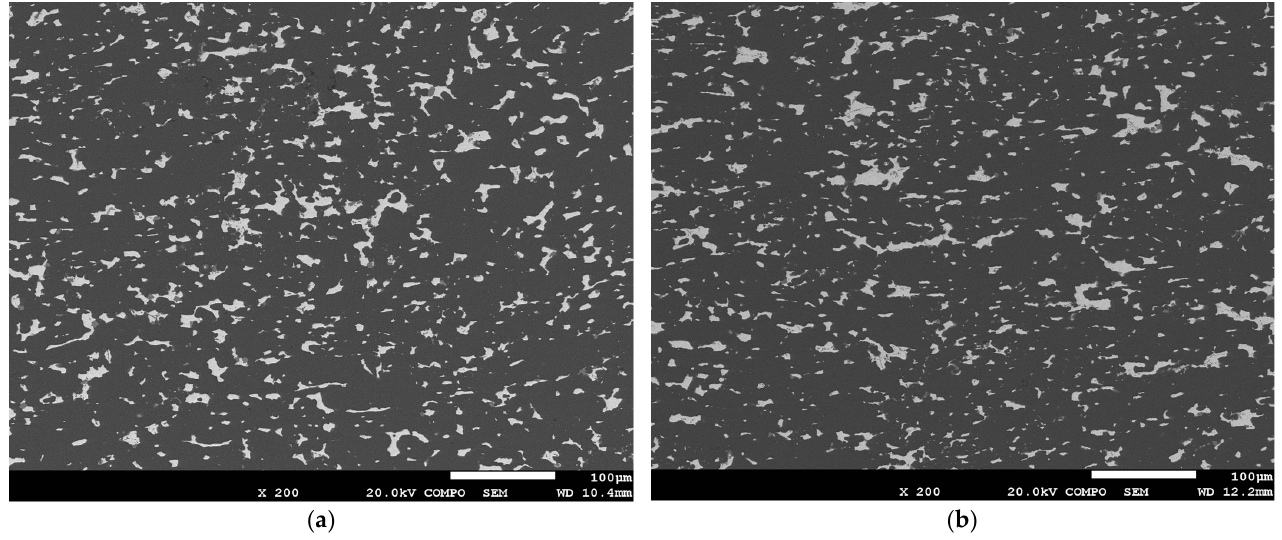
Figure 9. Scanning electron microscope (SEM) images of the final milled sheet: ( a ) S-T direction, and ( b ) L-S direction.